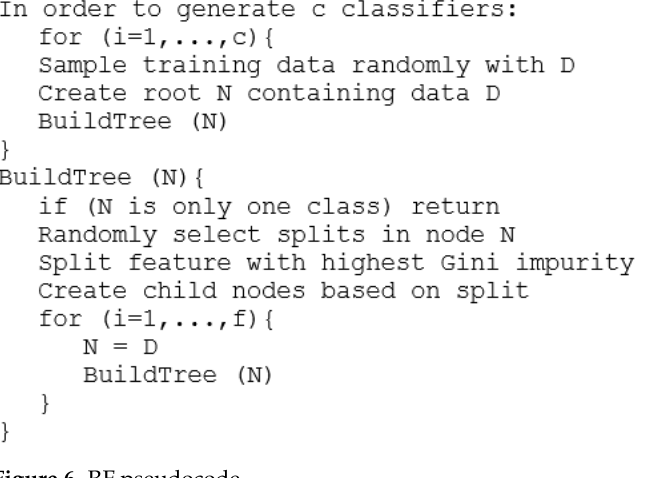
Figure 6. RF pseudocode.